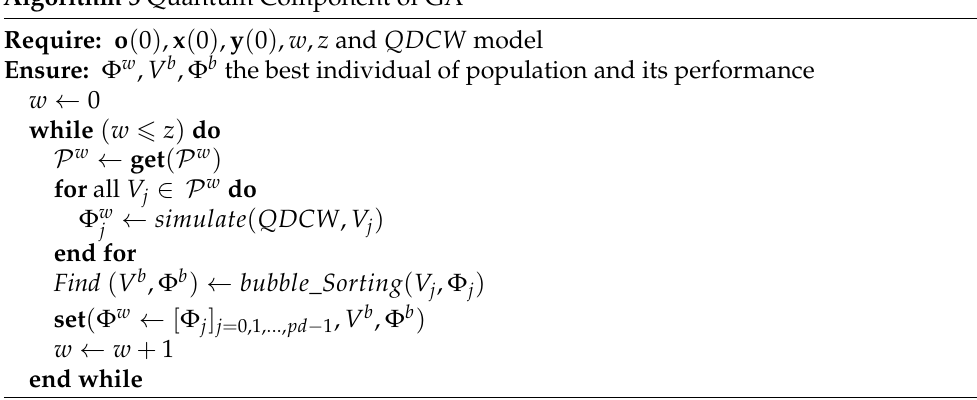
Algorithm 5 Quantum Component of